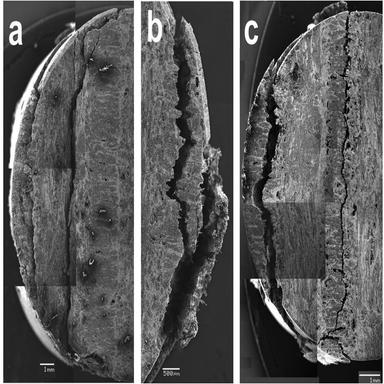
Low magnification SEM images of bottom surface of Cf-HfB2 powder composites after compressive testing along the plies. (a,b) Strongest sample (c) weakest sample.